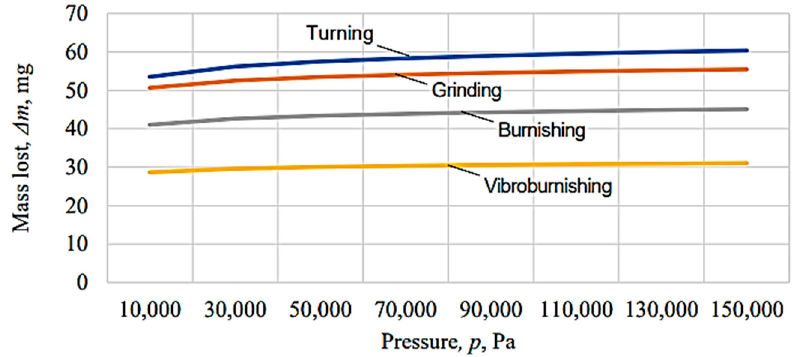
Figure 11. Influence exerted by the pressure on the mass lost Δ m for different machining processes applied to the tested surface ( t = 150 min).